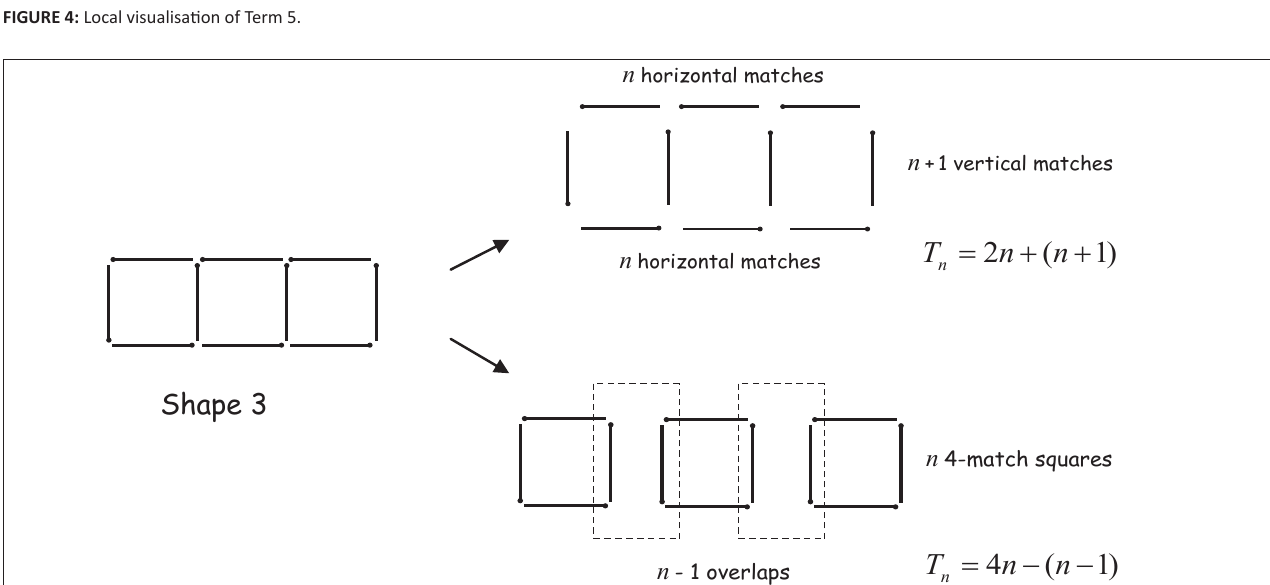
FIGURE 3: Term 3 and Term 5 of a typical pictorial sequence. FIGURE 4: Local visualisation of Term 5.